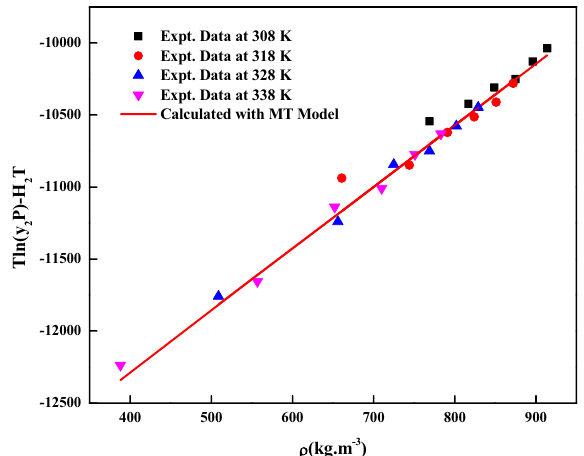
Figure 3. Solubility data self-consistency plot based on MT model.